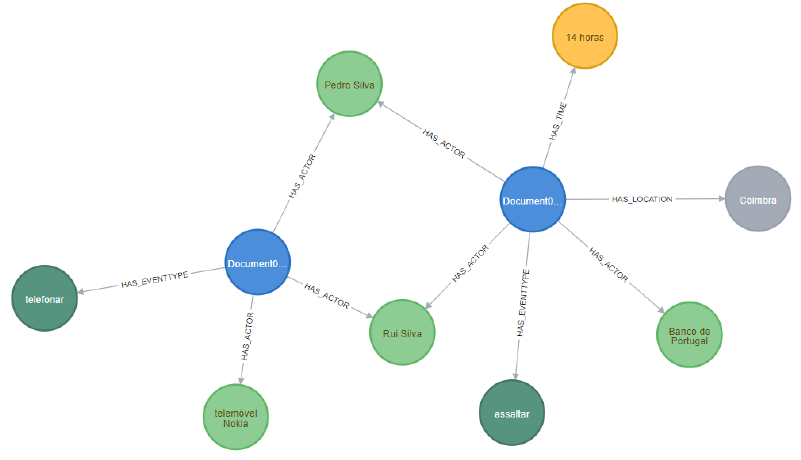
Figure 5. Neo4j representation of sentences.